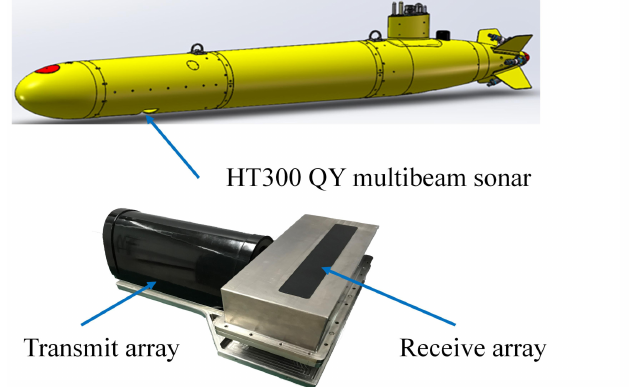
Figure 7. A photograph of the HT300 QY multibeam sonar equipped with an AUV.